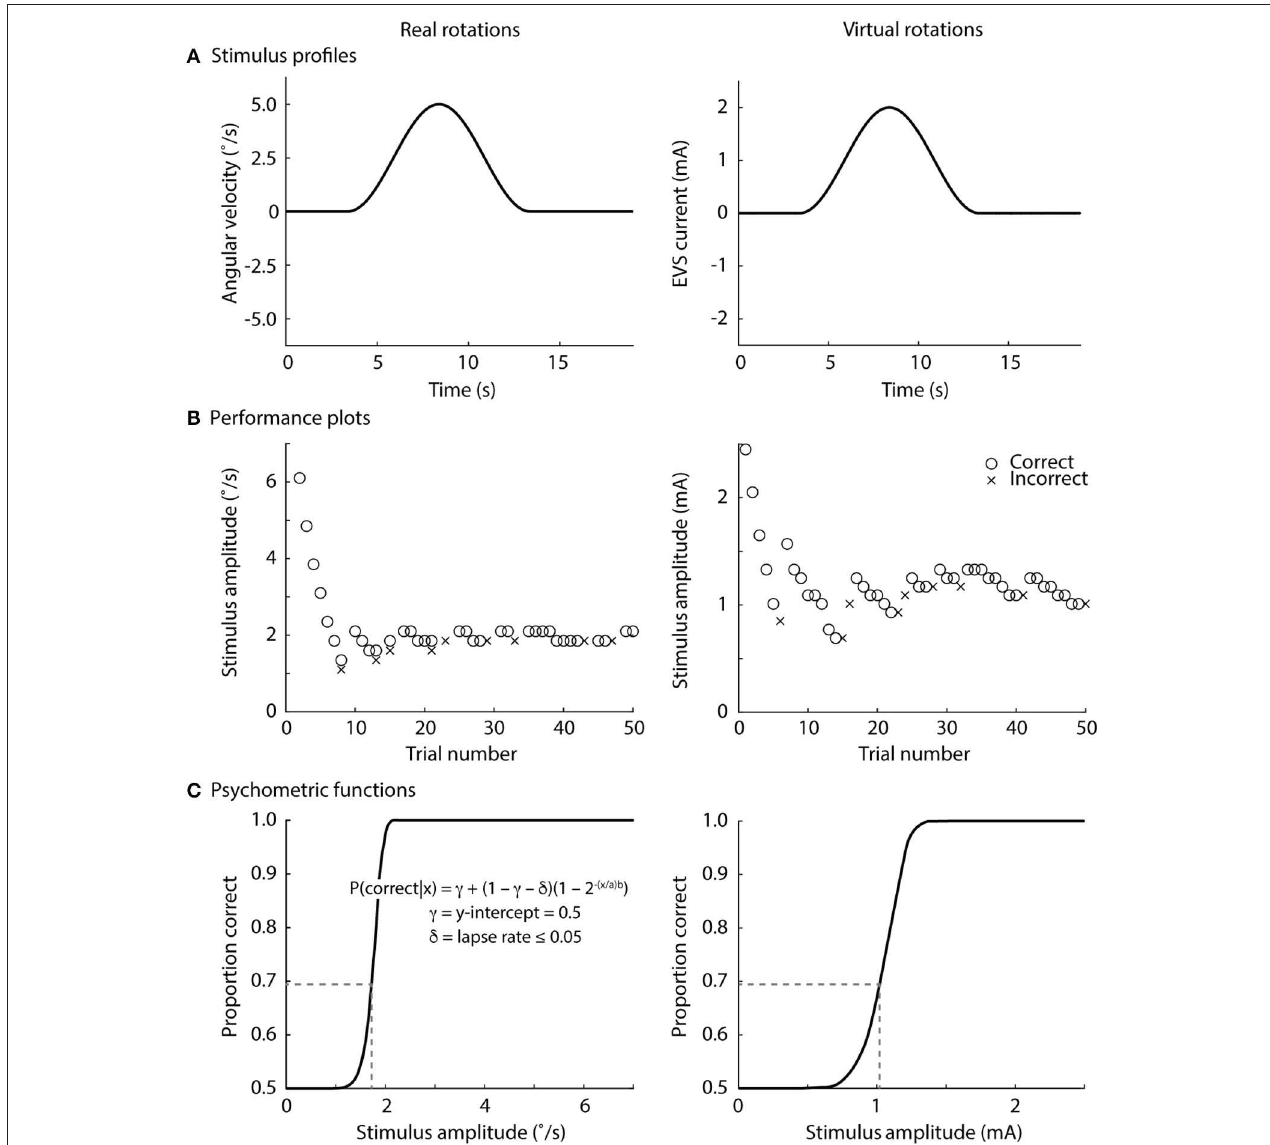
FIGURE 2 | Direction recognition thresholds for real and virtual rotations. (A) Stimulus profile, single cycle raised cosine curve at 0.1Hz; (B) exemplar performance plots, correct responses denoted by o’s and incorrect responses denoted in x’s; (C) exemplar psychometric functions fitted to the data in the exemplar performance plots. See text for an explanation of the psychometric equation. The stimulus level at 0.69 on the proportion-correct axis is the direction recognition threshold (dashed line). The lapse rate was ≤ 0.05 for the online analysis (during the experiments), but was set to zero for